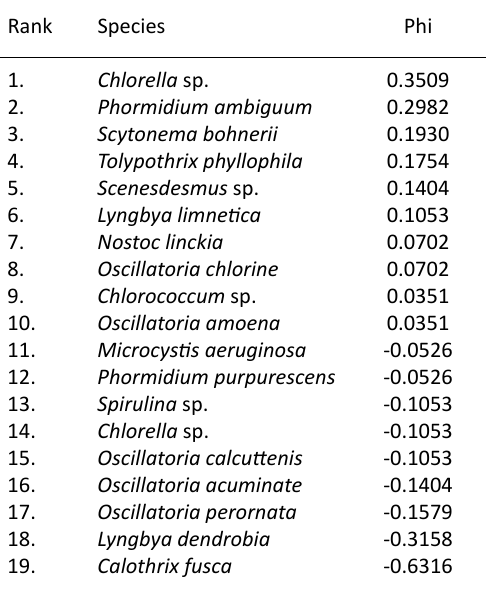
Table 5. Corresponding Ourranking